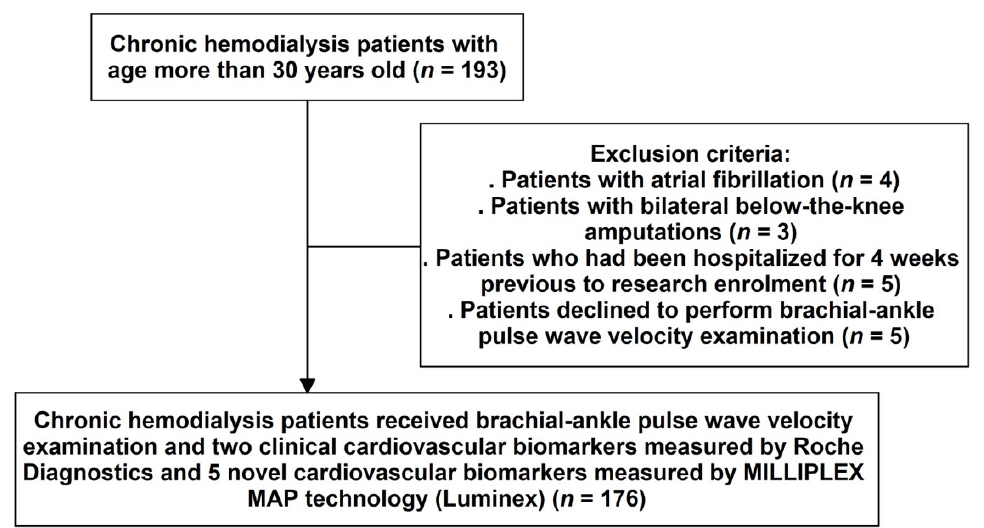
Figure 1. Sample derivation flowchart. Table 1. The baseline characteristics in hemodialysis